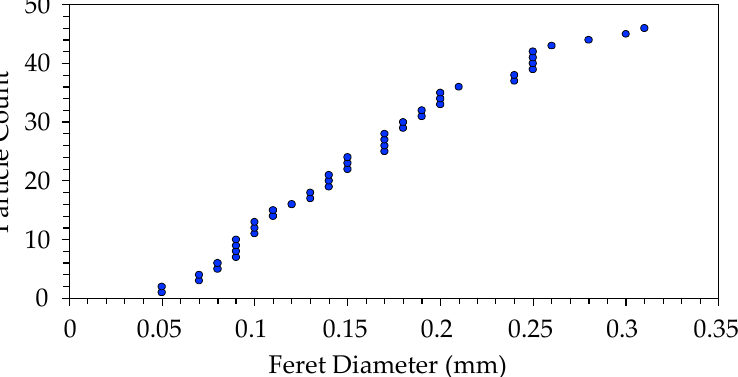
Figure 2. Particle Feret diameter and count of polyethylene terephthalate (PET). Mean Feret diameter of PET particles were found to be 0.16 ± 0.07 mm.